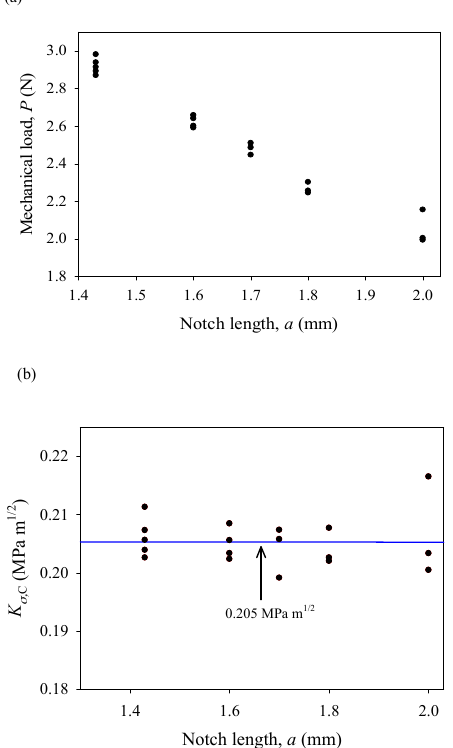
Figure 7. ( a ) Critical mechanical load versus the length of a pre-crack under a pure mechanical load and ( b ) the critical stress intensity factors of GaN PSCs.